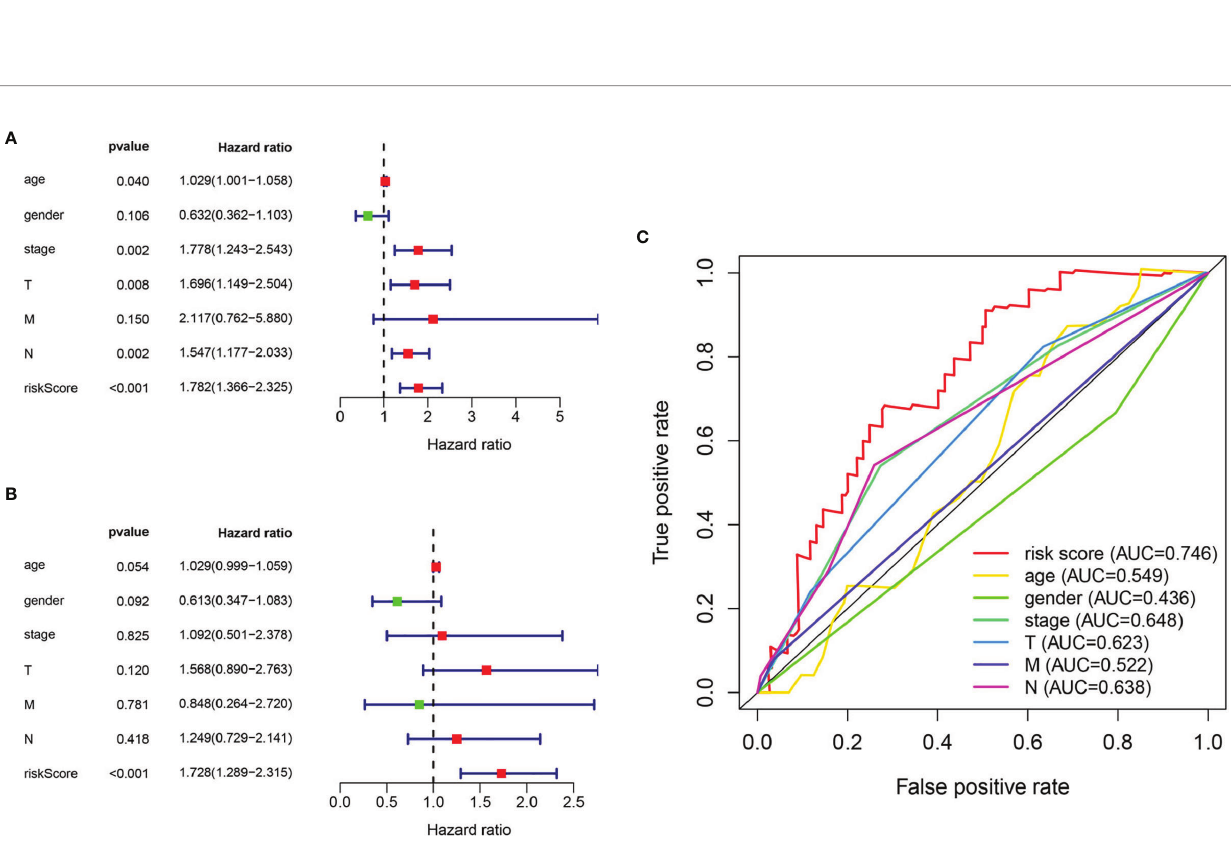
FIGURE 7 | Evaluation of pyroptosis prognosis model in BLCA. (A) Univariate cox regression analysis. (B) Multiple cox independent prognosis analysis. (C) ROC curve of clinicopathological features.